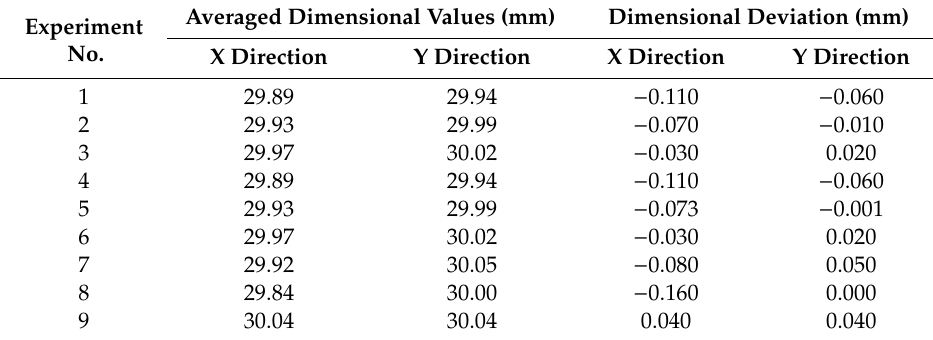
Table 4. Dimensional calculations.